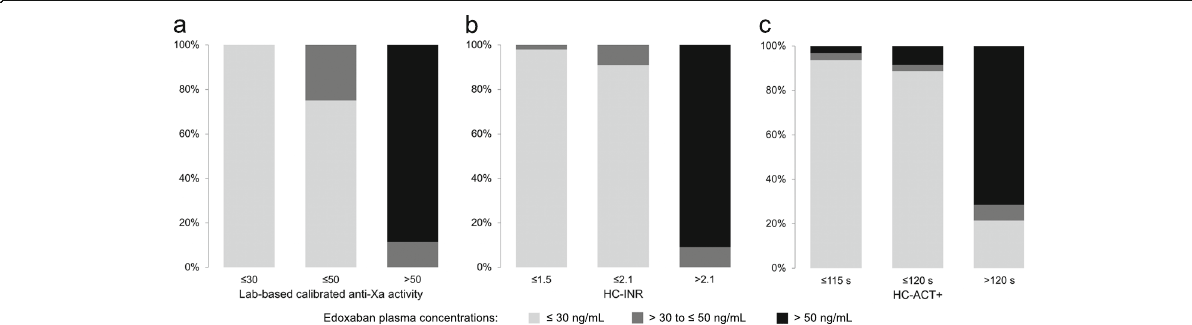
Fig. 2 Receiver operating characteristics curves found for laboratory-based calibrated anti-Xa activity all four Hemochron ™ Signature